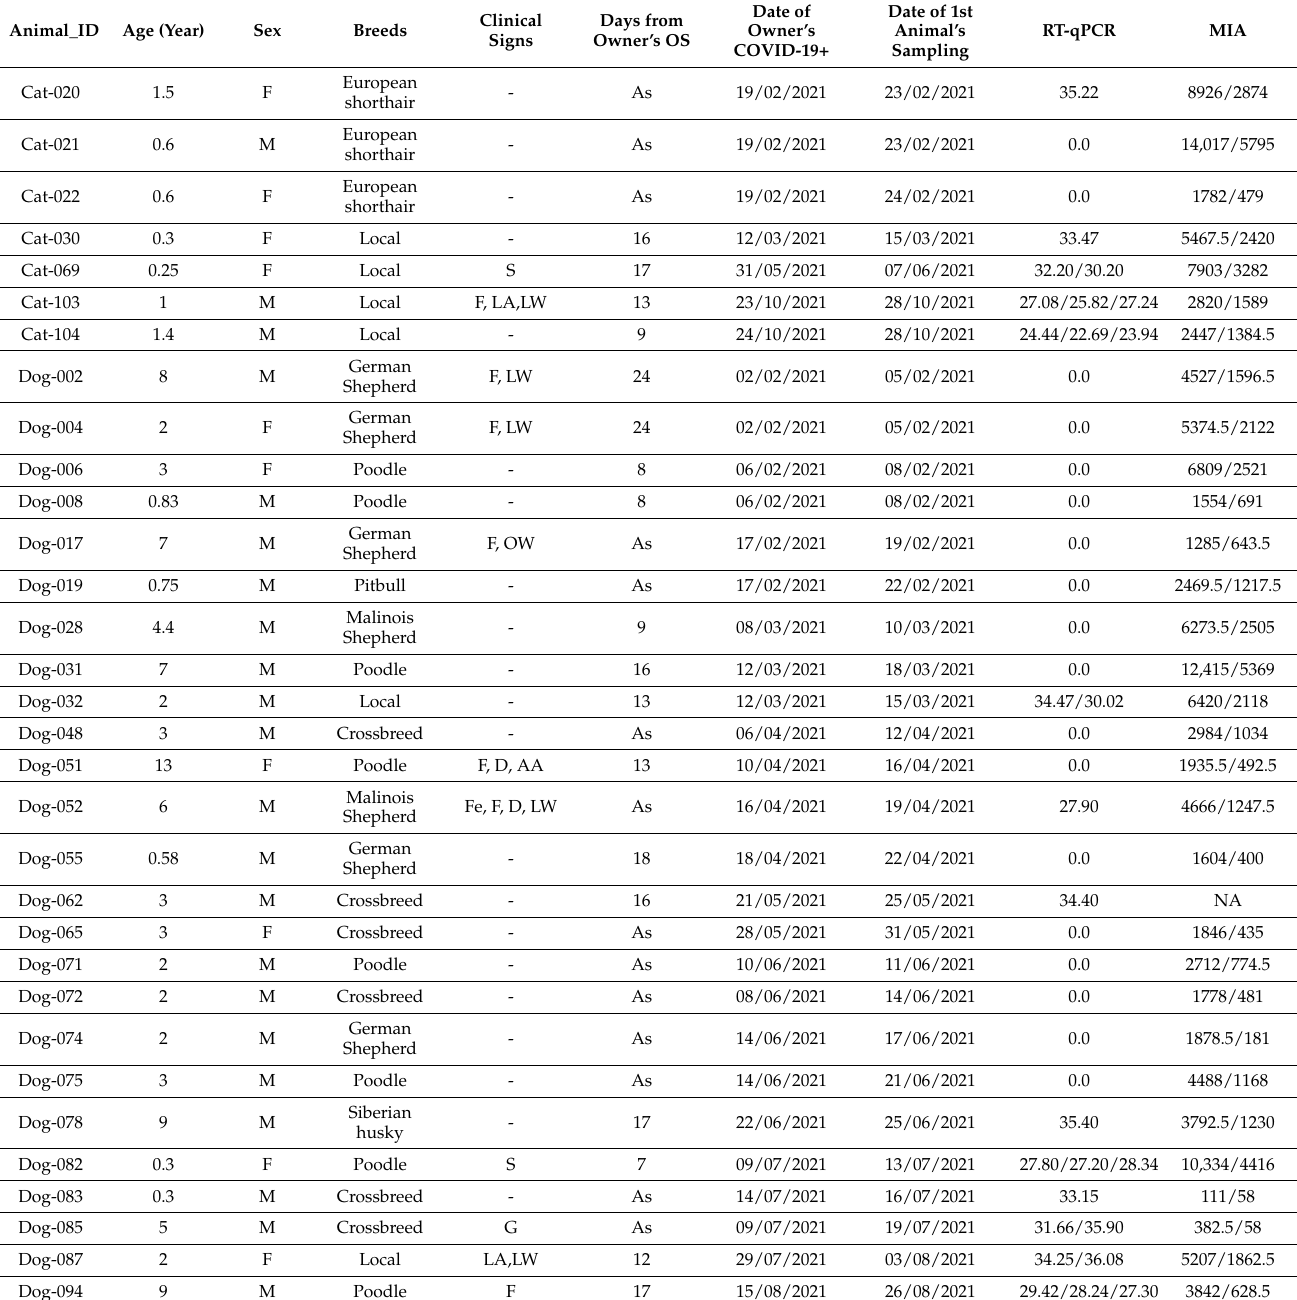
Table 1. Features of pets testing positive for SARS-CoV-2 by RT-qPCR and/or MIA in